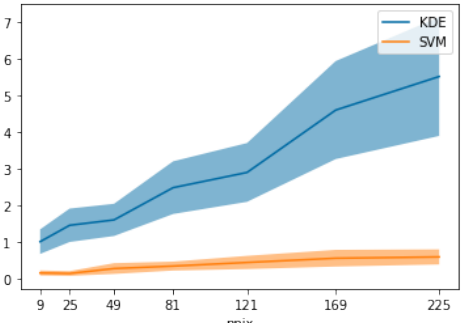
Figure 6. Chart comparing TPD computation time between KDE and SVM in relation to the number of data points.